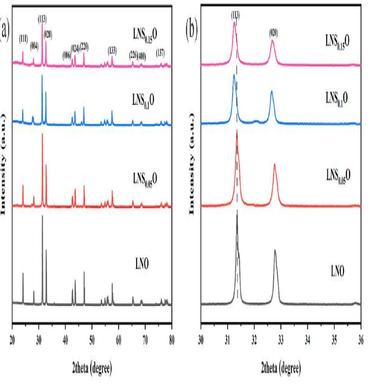
(a) XRD patterns of La2Ni1-xScxO4+δ (x = 0, 0.05, 0.10 and 0.15) cathode after calcination at 1100 ◦C (b) The magnified diffraction peak at 2θ = 30-36.